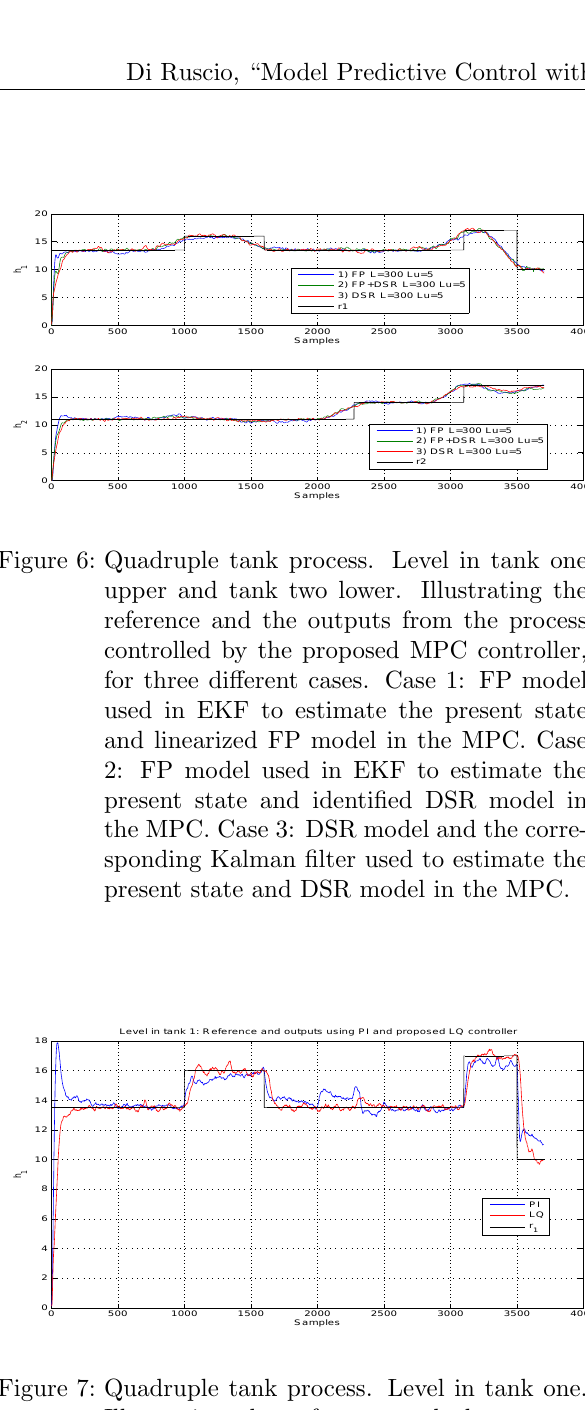
Figure 7: Quadruple tank process. Level in tank one. Illustrating the reference and the outputs from the process controlled by two single loop PI controllers, and the proposed LQ optimal controller with integral action. The LQ con- troller were constructed by using the DSR method for system identification. The DSR model was used to identify a Kalman filter for the system. The states were estimated with this Kalman filter and the determinis- tic part of the model were used to design the controller.